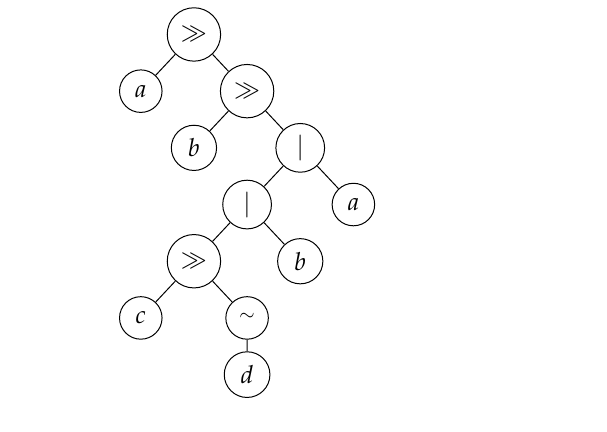
Figure 1. Example of a genetic programming individual coded as the expression a (cid:29) b (cid:29) ( c (cid:29) ∼ d | b | a